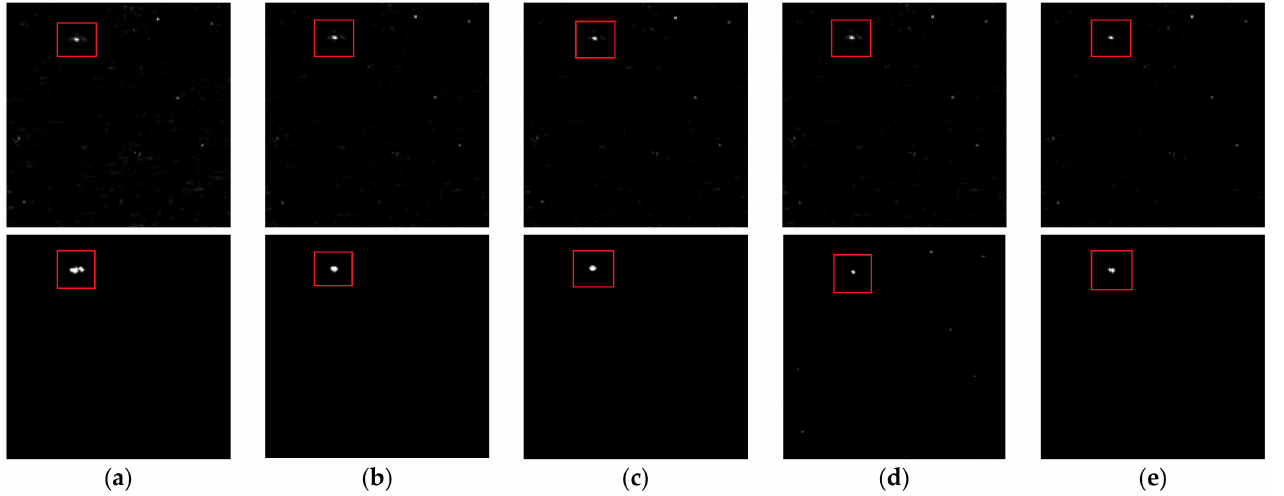
Figure 12. Smooth sea clutter. ( a ) Top-hat. ( b ) Spatial dynamics. ( c ) Temporal dynamics. ( d ) Spatio- temporal filter. ( e ) Proposed